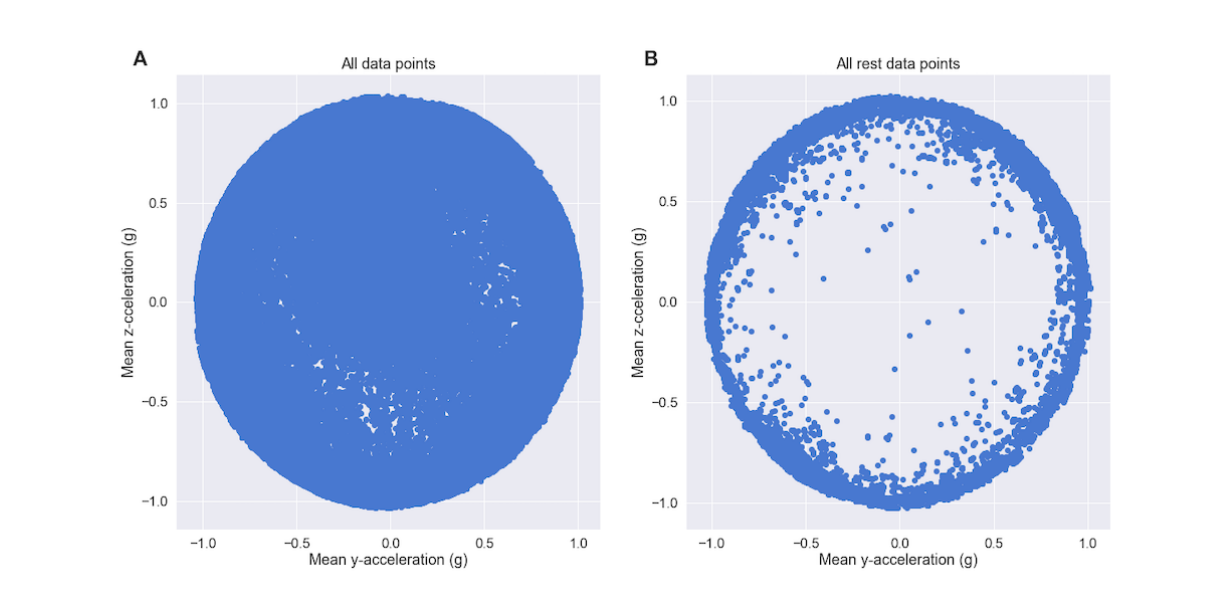
Figure 7. The y–z acceleration circular deviation. (A) Mean z-axis acceleration versus mean y-axis acceleration for all data points in units of g. (B) Mean z-axis acceleration versus mean y-axis acceleration for all rest data points in units of g. Note that, for the remaining data points, the y-axis and z-axis accelerations tend to cluster around a circle with radius 1. Thus, the circular deviation in the y–z plane is an effective feature for differentiating rest from